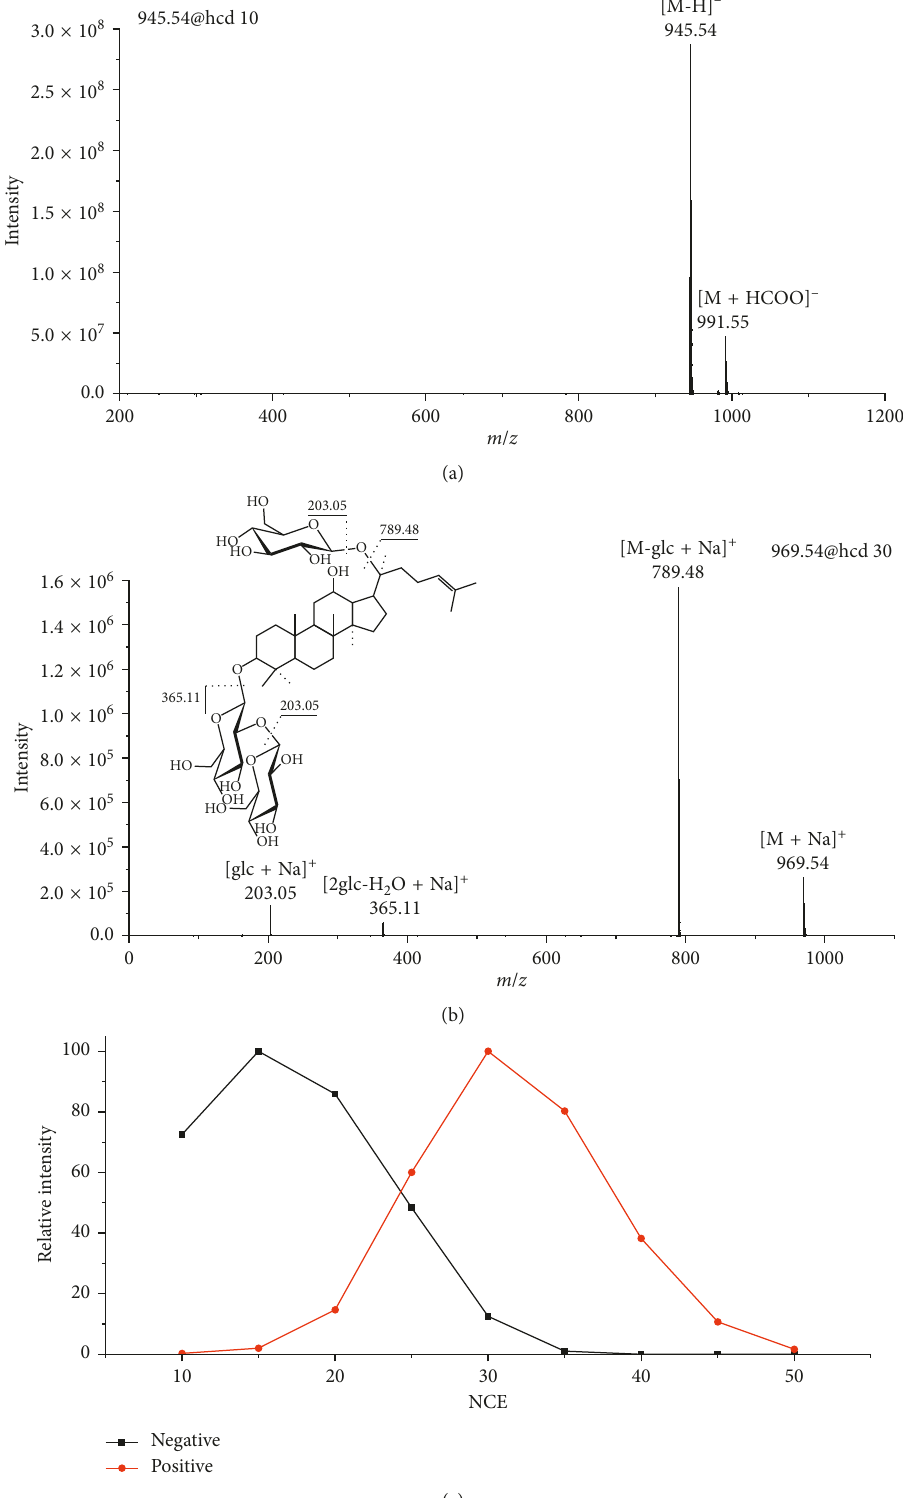
Figure 2: MS 2 spectra of (a) [M +HCOO] (glc represents